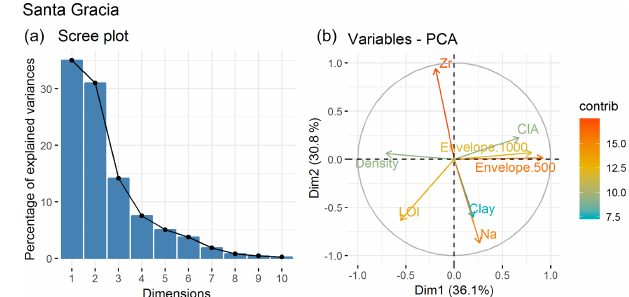
Figure 7. Principal component analysis (PCA) of properties for all four pedons in Santa